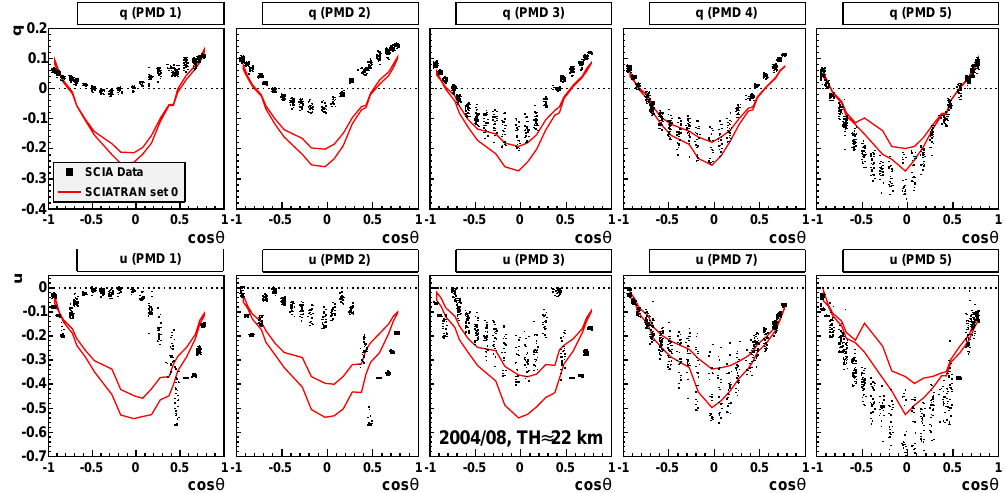
Fig. 3. Values for q and u from the SCIAMACHY data of August 2004 (black points) for each PMD and from SCIATRAN simulations (red lines depicting the 1 σ envelope of the expected distribution around the mean) at TH ≈